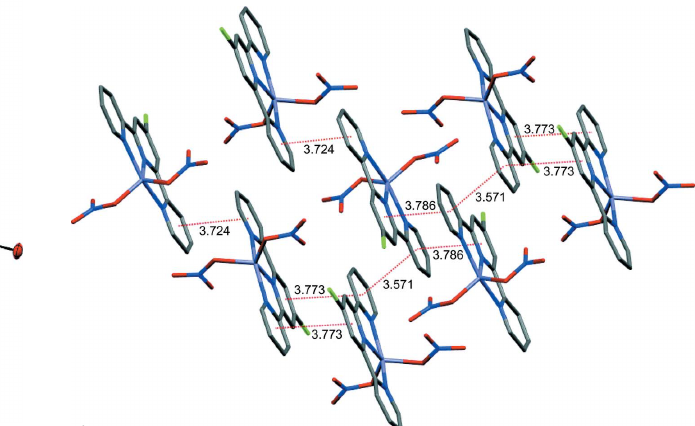
Figure 2 Perspective view of the packing structure of the title complex along the crystallographic b axis; H atoms are omitted for clarity.